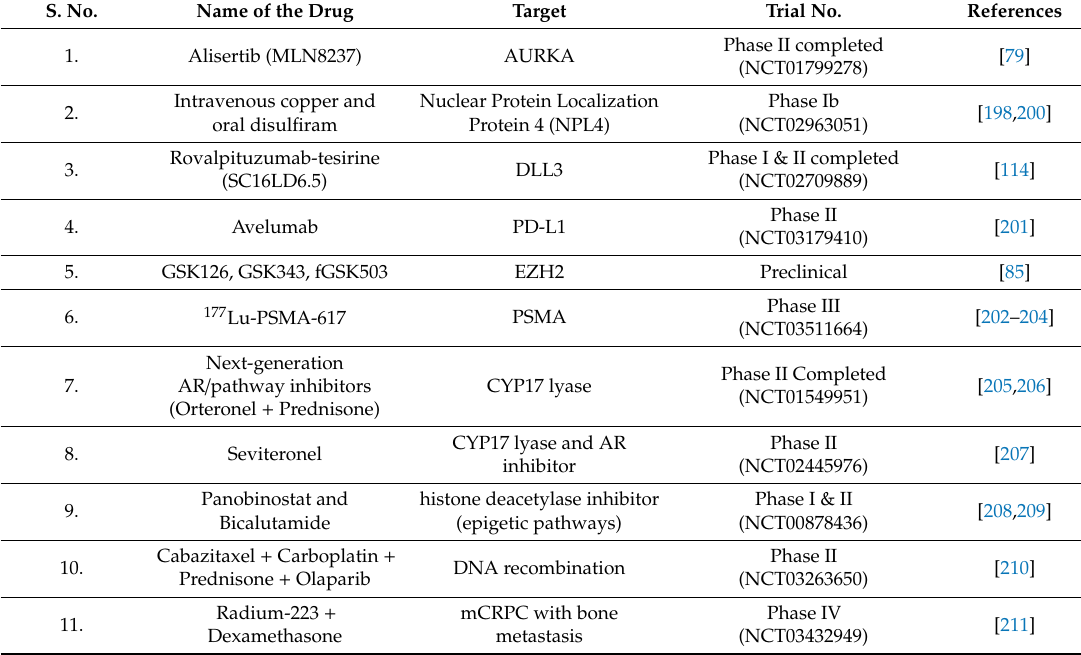
Table 3. Summary of some ongoing clinical trials in